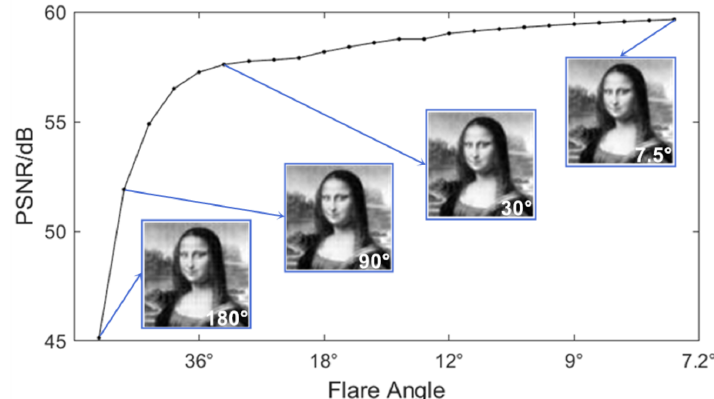
Figure 6. PSNR curve of different flare angles of wavefront recording plane